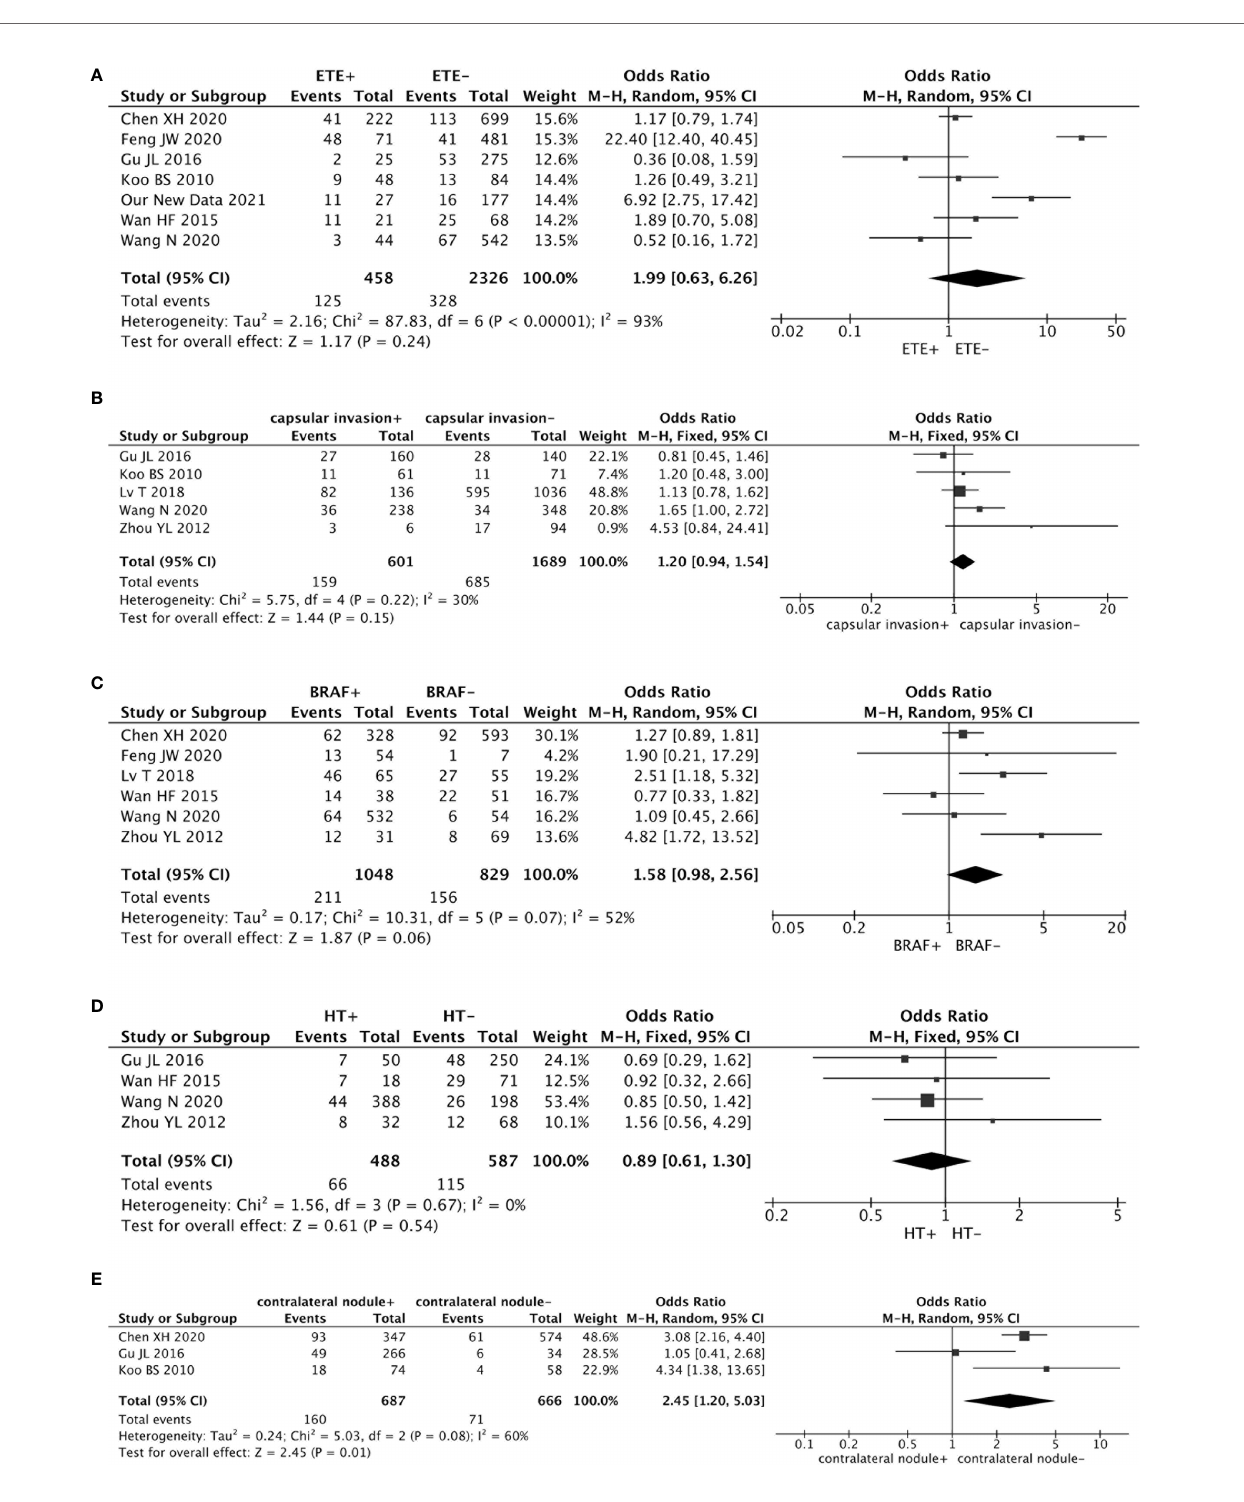
FIGURE 3 | Forest plots of the association between contralateral occult PTC and all factors: (A) There was no signi fi cant association between ETE and contralateral occult PTC (pooled OR = 1.99, 95% CI = 0.63 – 6.26, p = 0.24); (B) The risk of capsular invasion was not associated with contralateral occult PTC (pooled OR = 1.20, 95% CI = 0.94 – 1.54, p = 0.15); (C) There was no signi fi cant association between a BRAF mutation and contralateral occult PTC (pooled OR = 1.58, 95% CI = 0.98 – 2.56, p = 0.06); (D) The risk of HT was not associated with contralateral occult PTC (pooled OR = 0.89, 95% CI = 0.61 – 1.30, p = 0.54); (E) Compared with patients without a contralateral benign nodule, patients with a contralateral benign nodule had a higher prevalence of contralateral occult PTC (pooled OR = 2.45, 95% CI = 1.20 – 5.03, p =